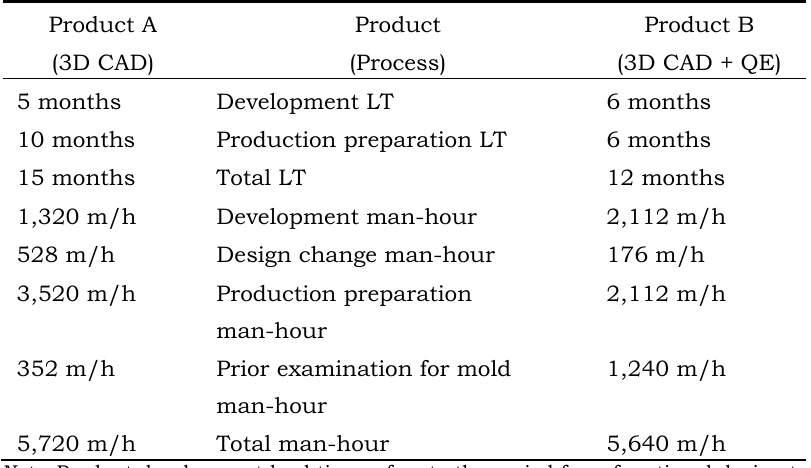
Table 3. Development performances of Product A and Product